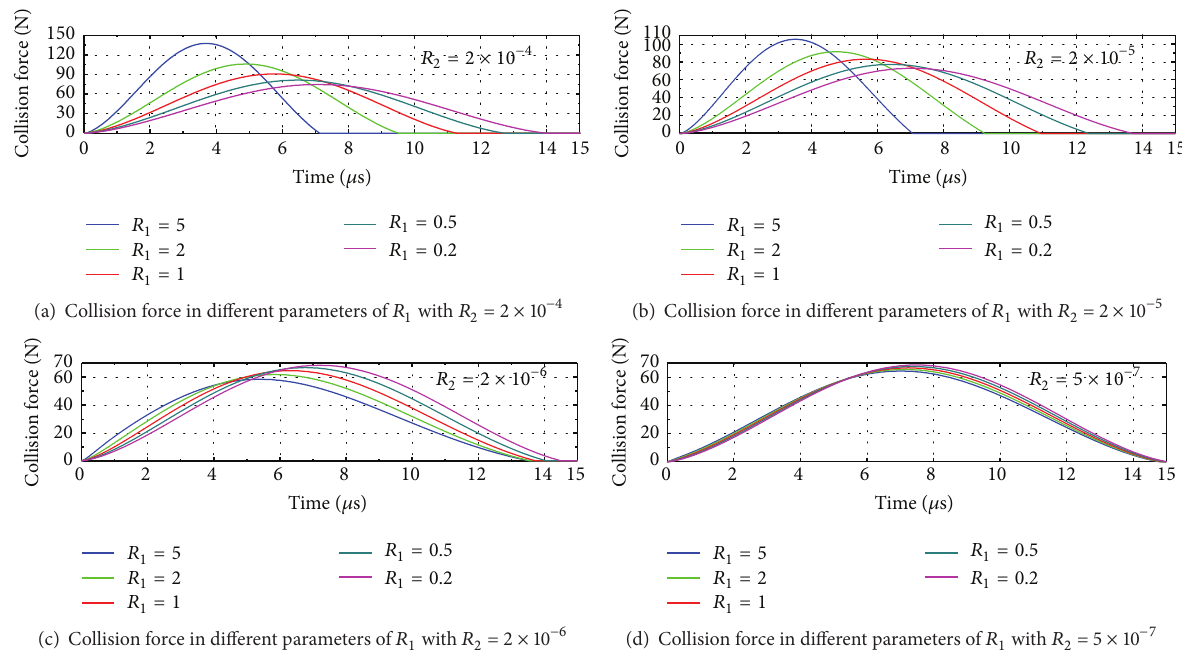
Figure 7: Collision force influenced by parameters of 𝑅 1 with different 𝑅 2 .